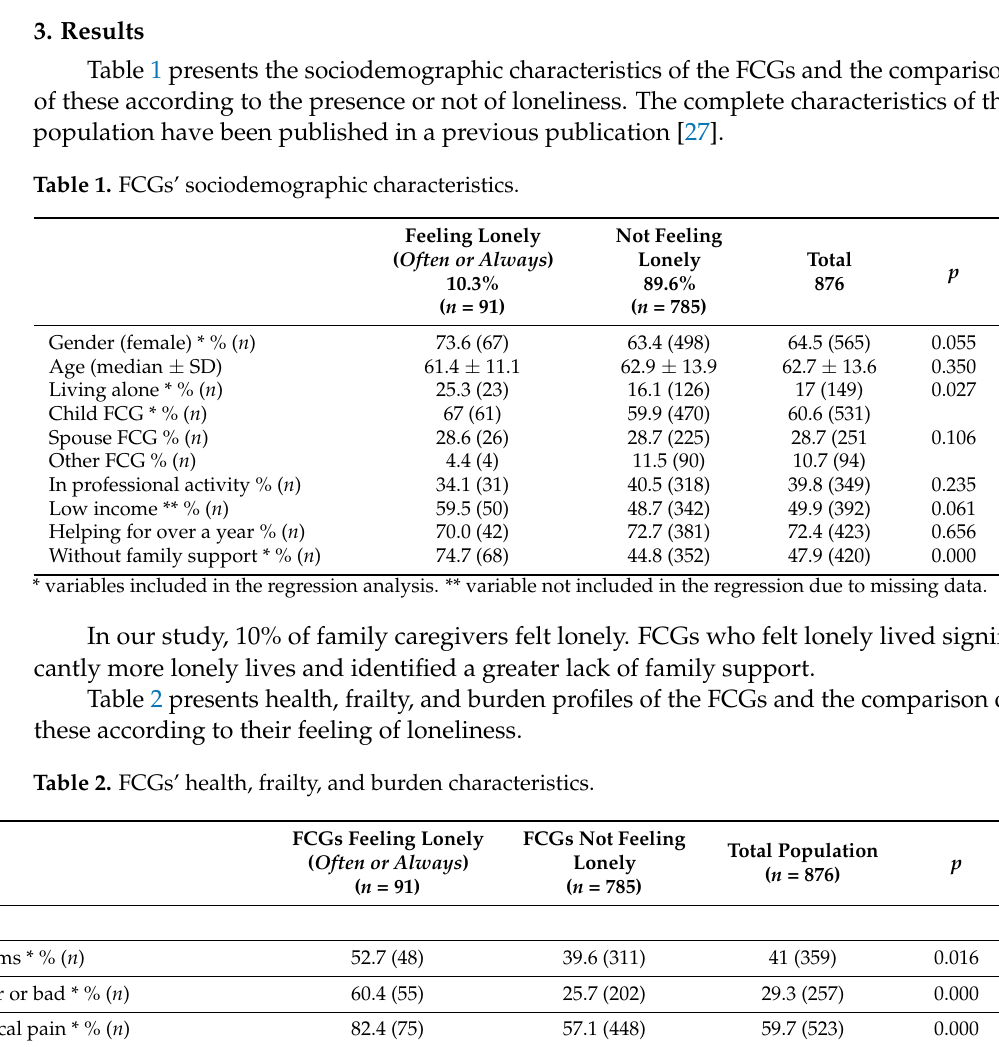
Table 1. FCGs’ sociodemographic characteristics.